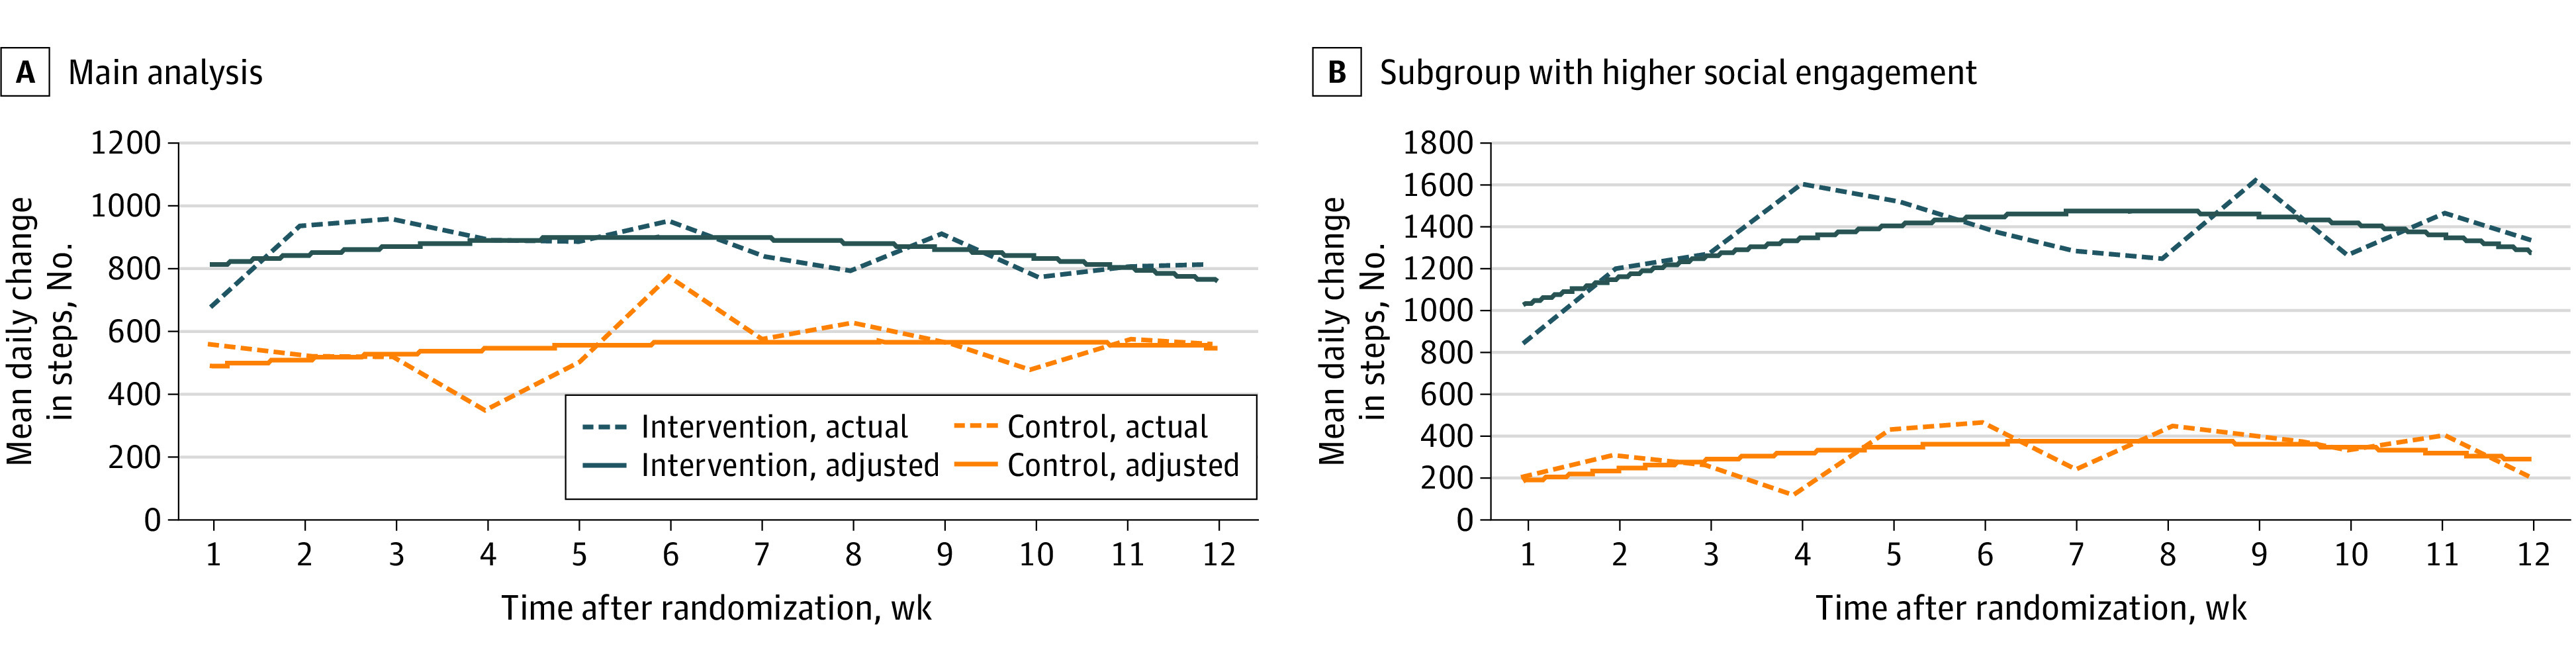
Unadjusted Increase in Mean Daily Steps From BaselineDepicted are the changes in mean daily steps for each group by week after enrollment using imputed data. Dashed lines represent actual values and solid lines represent adjusted values. Panel A shows findings for the main analysis (118 participants in the control group and 114 participants in the intervention group), and panel B shows findings for the subgroup with higher social engagement (40 participants in the control group and 36 participants in the intervention group).